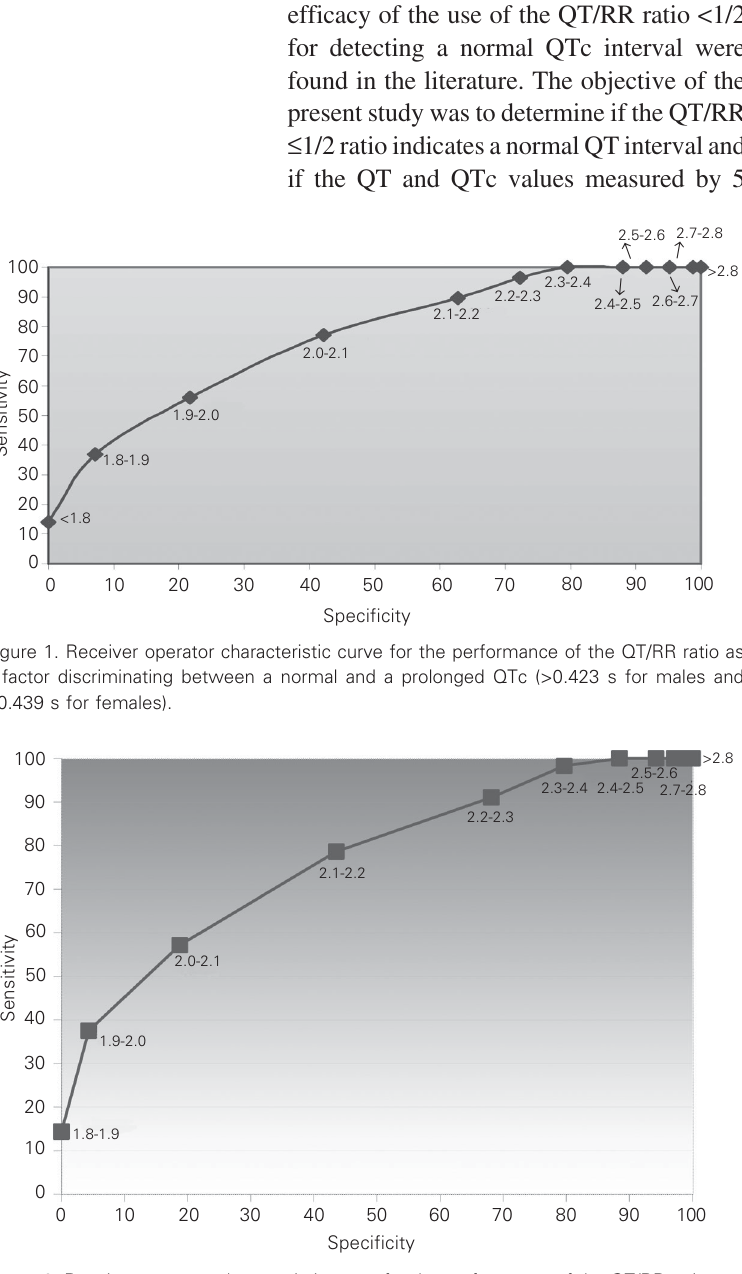
Figure 2. Receiver operator characteristic curve for the performance of the QT/RR ratio as a factor identifying a prolonged Qtc (>0.423 s for males and >0.439 s for females), with heart rate between 60 and 100